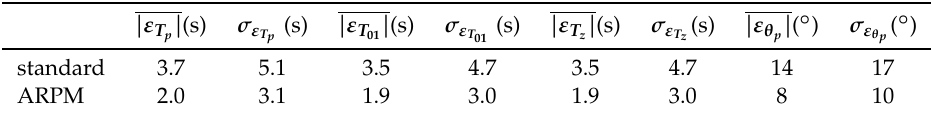
Table 3. Comparison of the ARPM and the standard method in wave period and peak direction